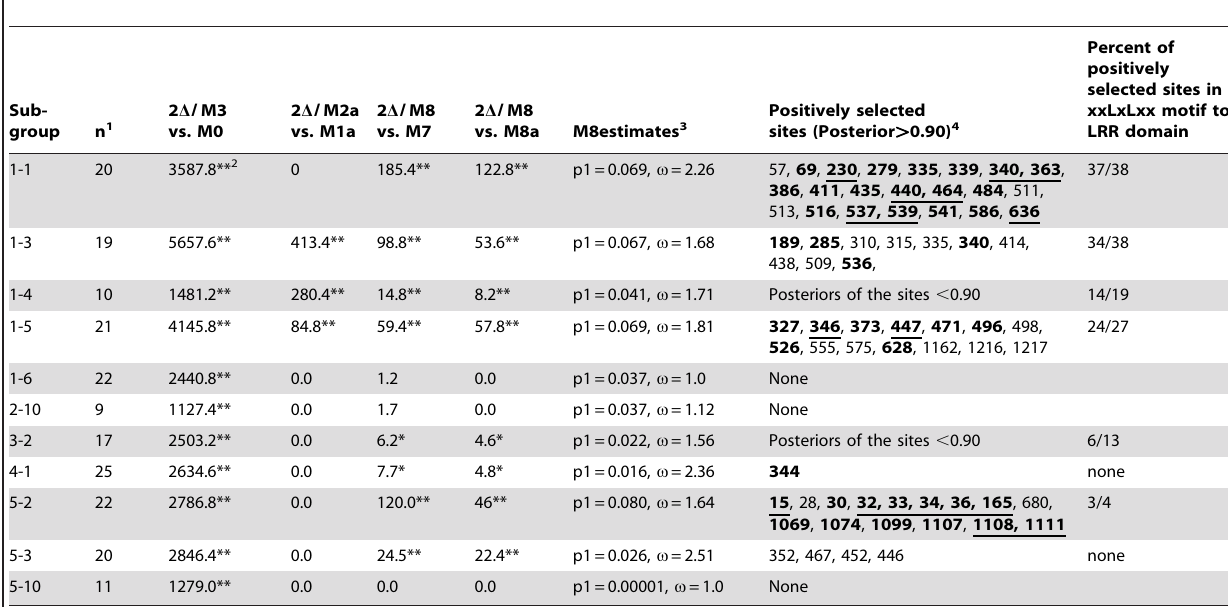
Table 5. Likelihood ratio test of positive selection in family proteins.